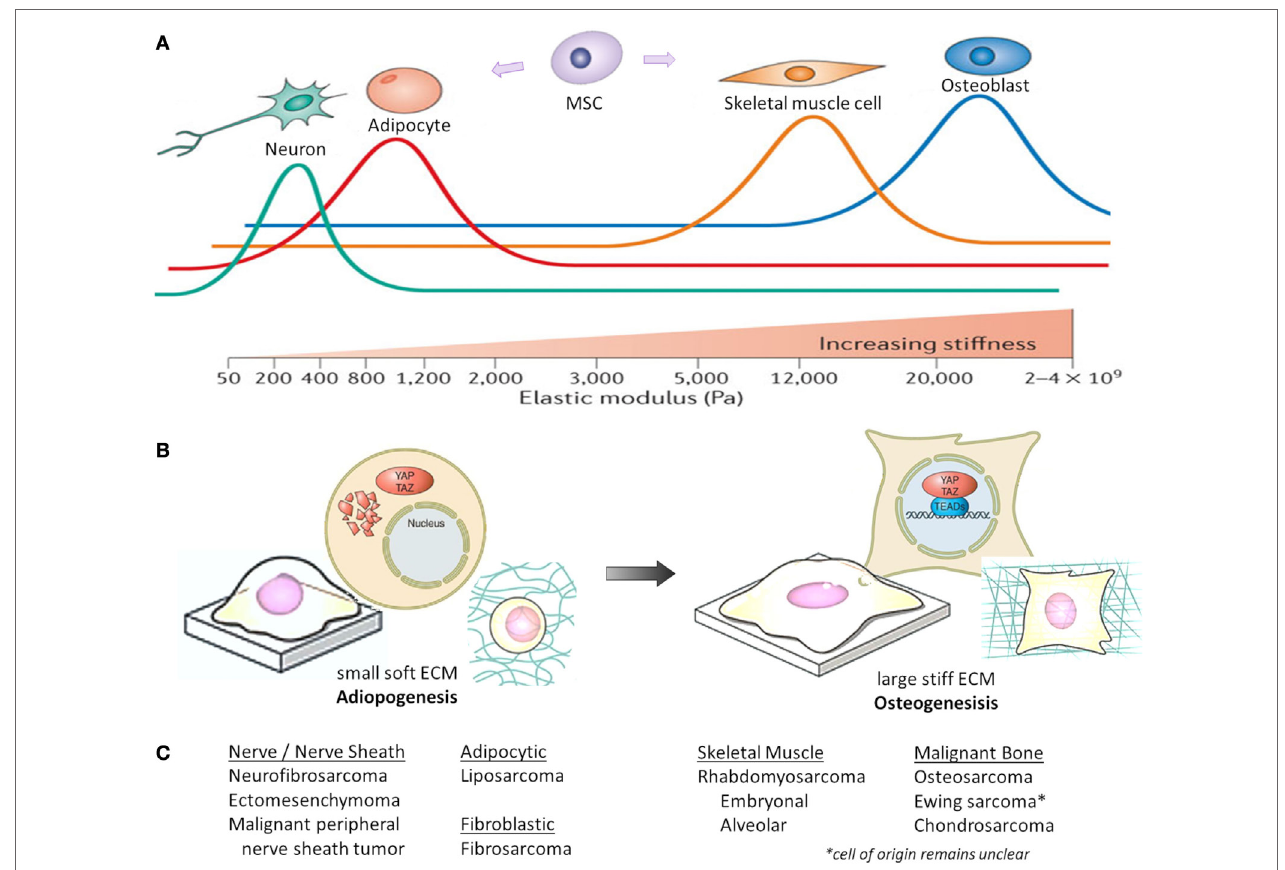
into a small round shape, YAP/TAZ remain inhibited in the cytoplasm and MSCs differentiate into adipocytes. However, when MSCs are either grown on a stiff matrix or stretched and manipulated into a “spread-out” morphology, YAP/TAZ localize to the nucleus as MSCs differentiate into osteoblasts. (C) Corresponding histologic sarcoma subtype [2013 WHO classification (230)], which may reflect varying lineage differentiation from mesenchymal progenitor cells. This represents only a theoretical link between mechanotransduction influencing mesenchymal progenitors and sarcoma, and not all sarcoma subtypes are represented. Figures (A,B) are modified with permission from Halder et al. (108) and Piccolo et al.